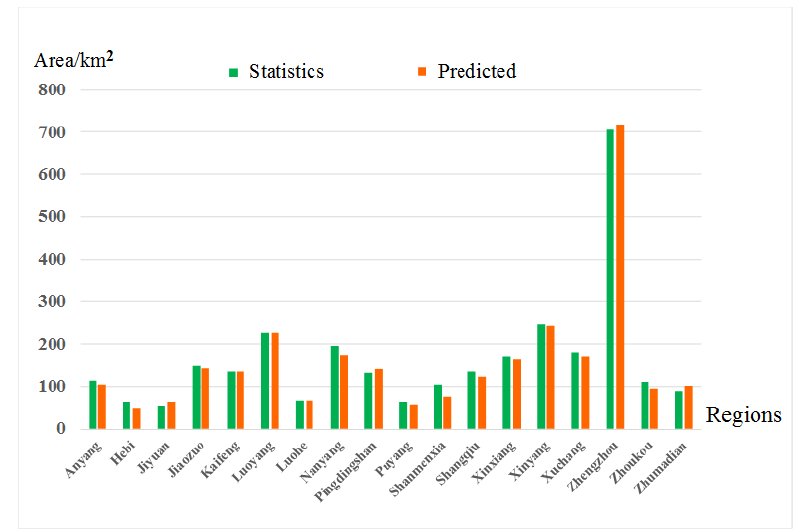
Figure 11. Comparison between the predicted area and the official statistical area in Henan Province.